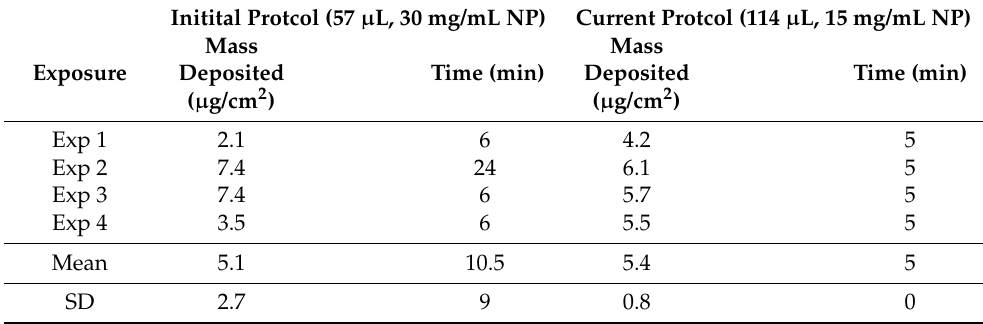
Table 1. TiO 2 NP mass deposition comparison between the initial exposure protocol and the current protocol (asymptotic values at the end are reported). Exp1, exp2, exp3 and exp4 are abbreviations for the replicates of the